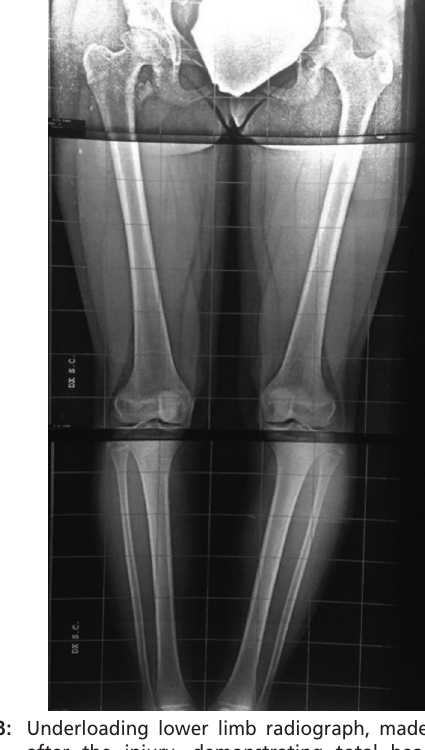
Underloading lower limb radiograph, made four years Fig. 3: after the injury, demonstrating total healing of the greater trochanter, a dysmorphic right femoral head and no leg length